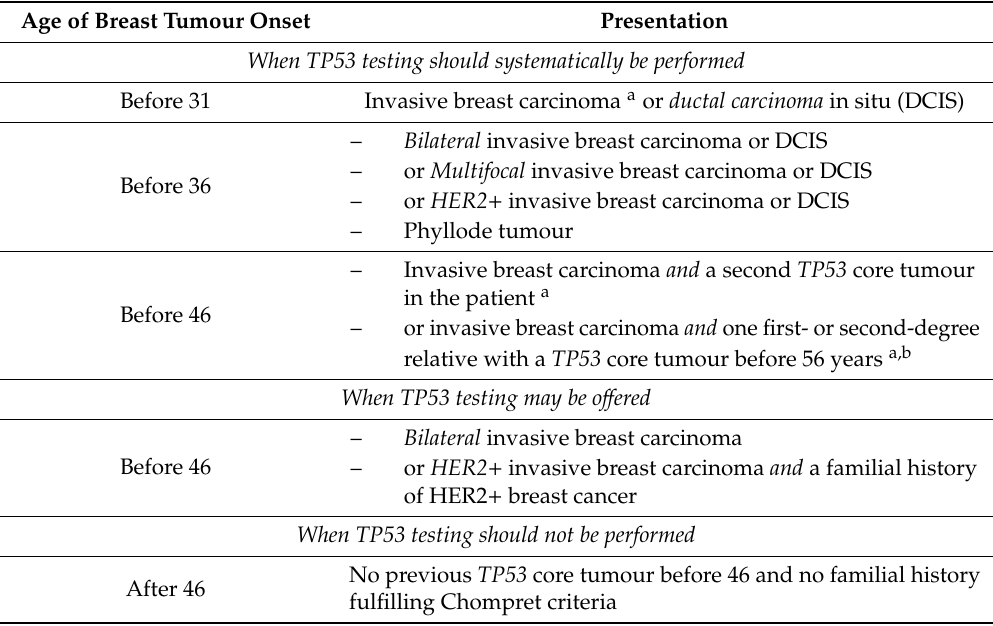
Table 3. Germline TP53 testing in Women with Breast